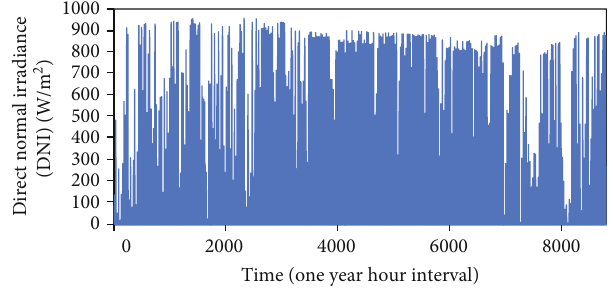
Figure 5: Annual DNI in an hourly interval.